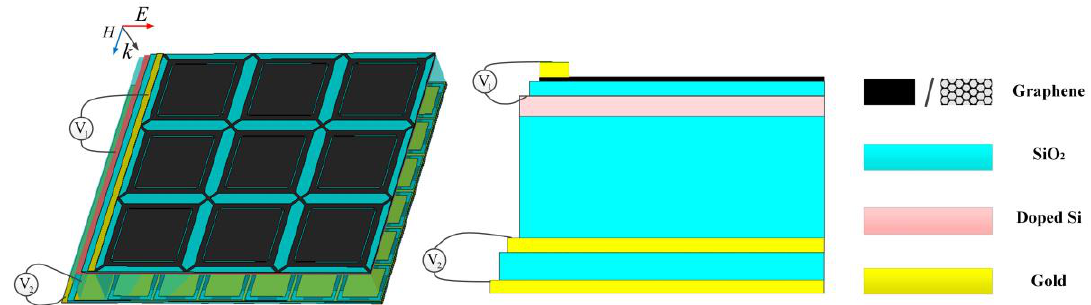
Figure 4. Schematic of the independently tunable dual-band absorber.